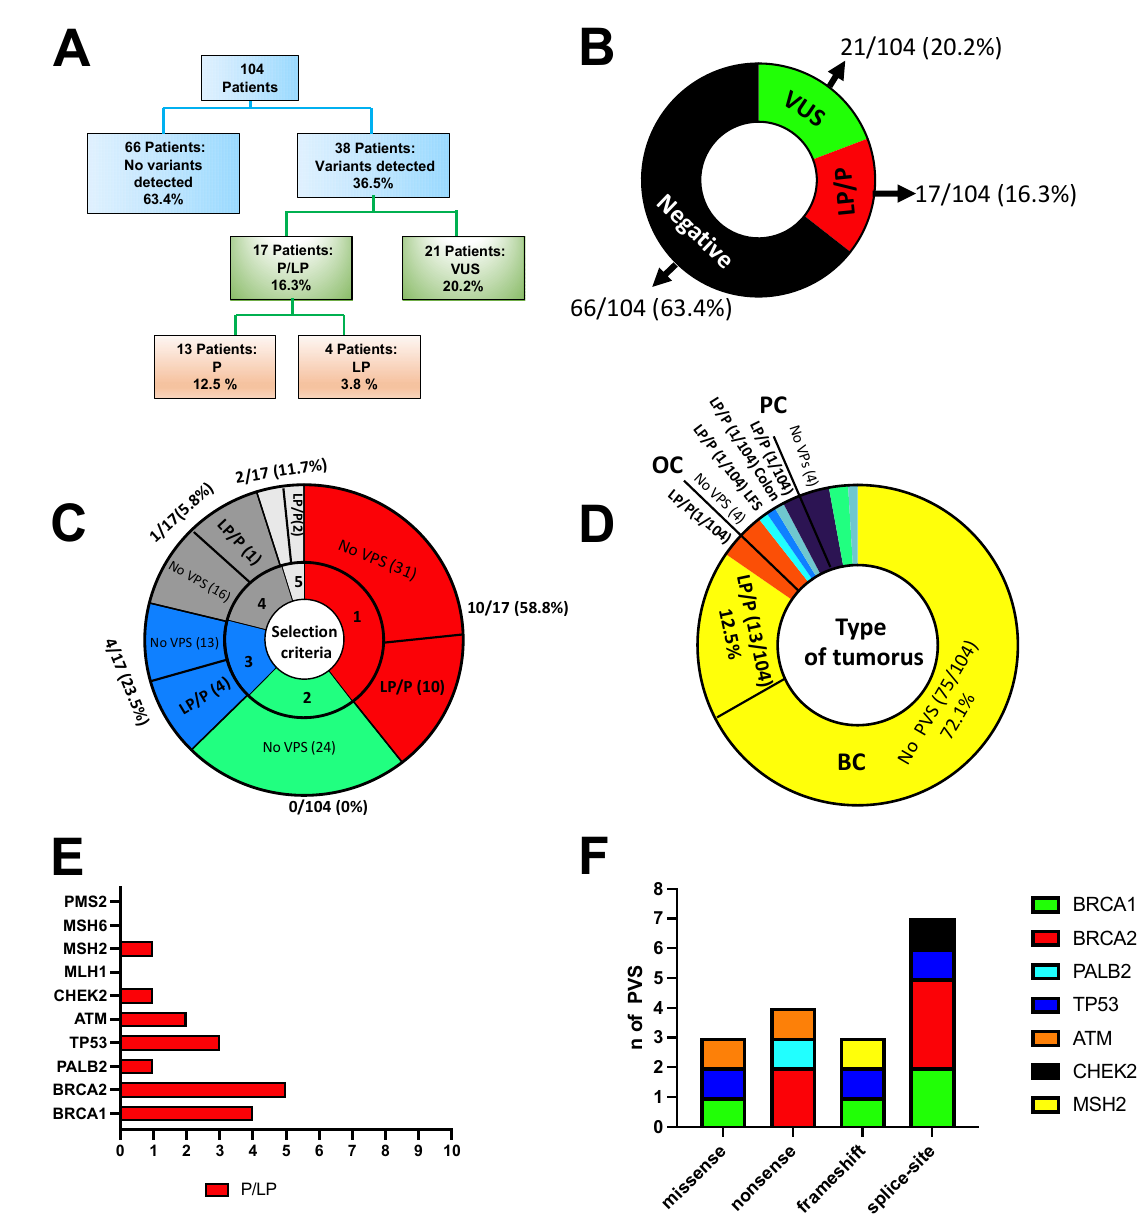
Figure 5. ( A ) Overall results of NGS panel testing. Importantly, the VUS rate does not include VUS detected in patients with P/LP variants. ( B ) Outcomes of panel testing for the 104 individuals tested. ( C ) Distribution of PVs concerning enrolling criteria. ( D ) Distribution of PVs among tumours. ( E ) Distribution of PVs among genes. ( F ) Distribution of 17 pathogenic variants by effect.